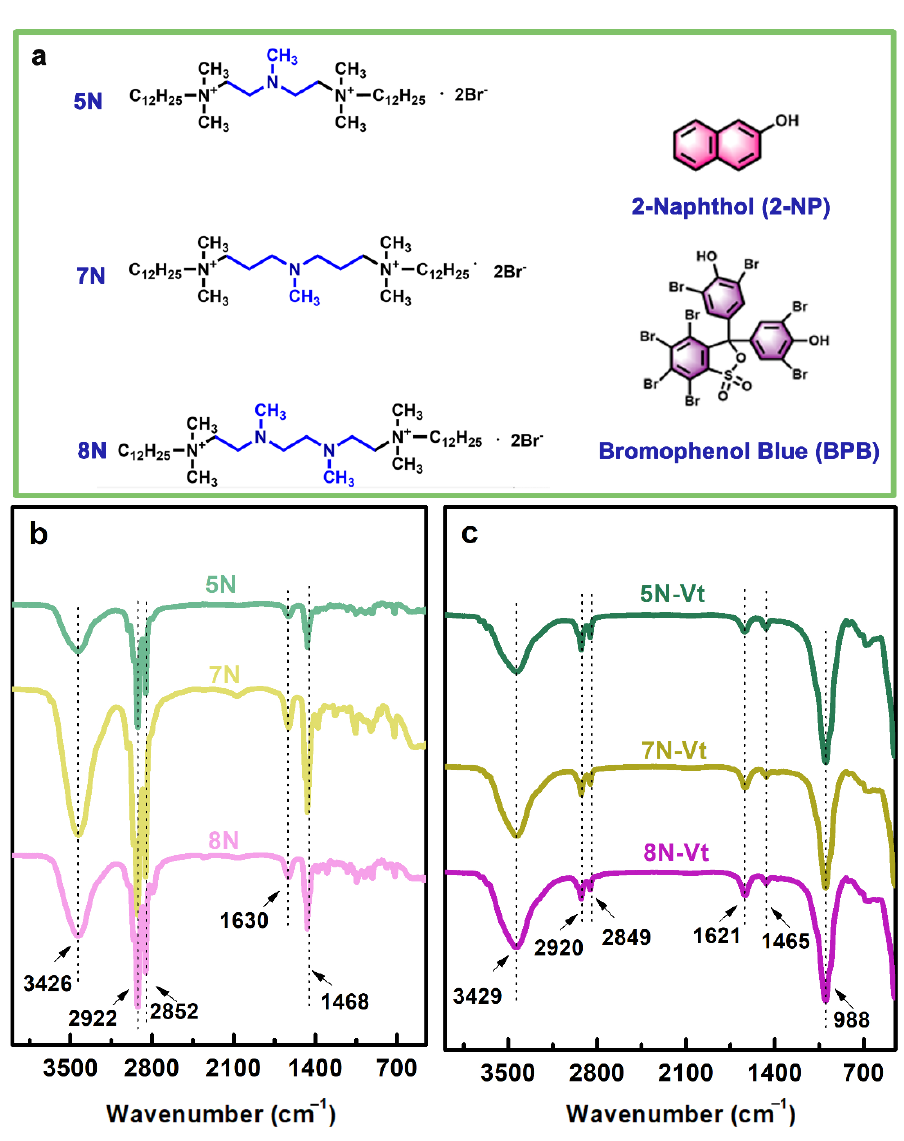
Figure 1. The chemical structures of surfactants, 2-NP and BPB ( a ), FT-IR spectra of surfactants ( b ) and organo-Vts ( c ).